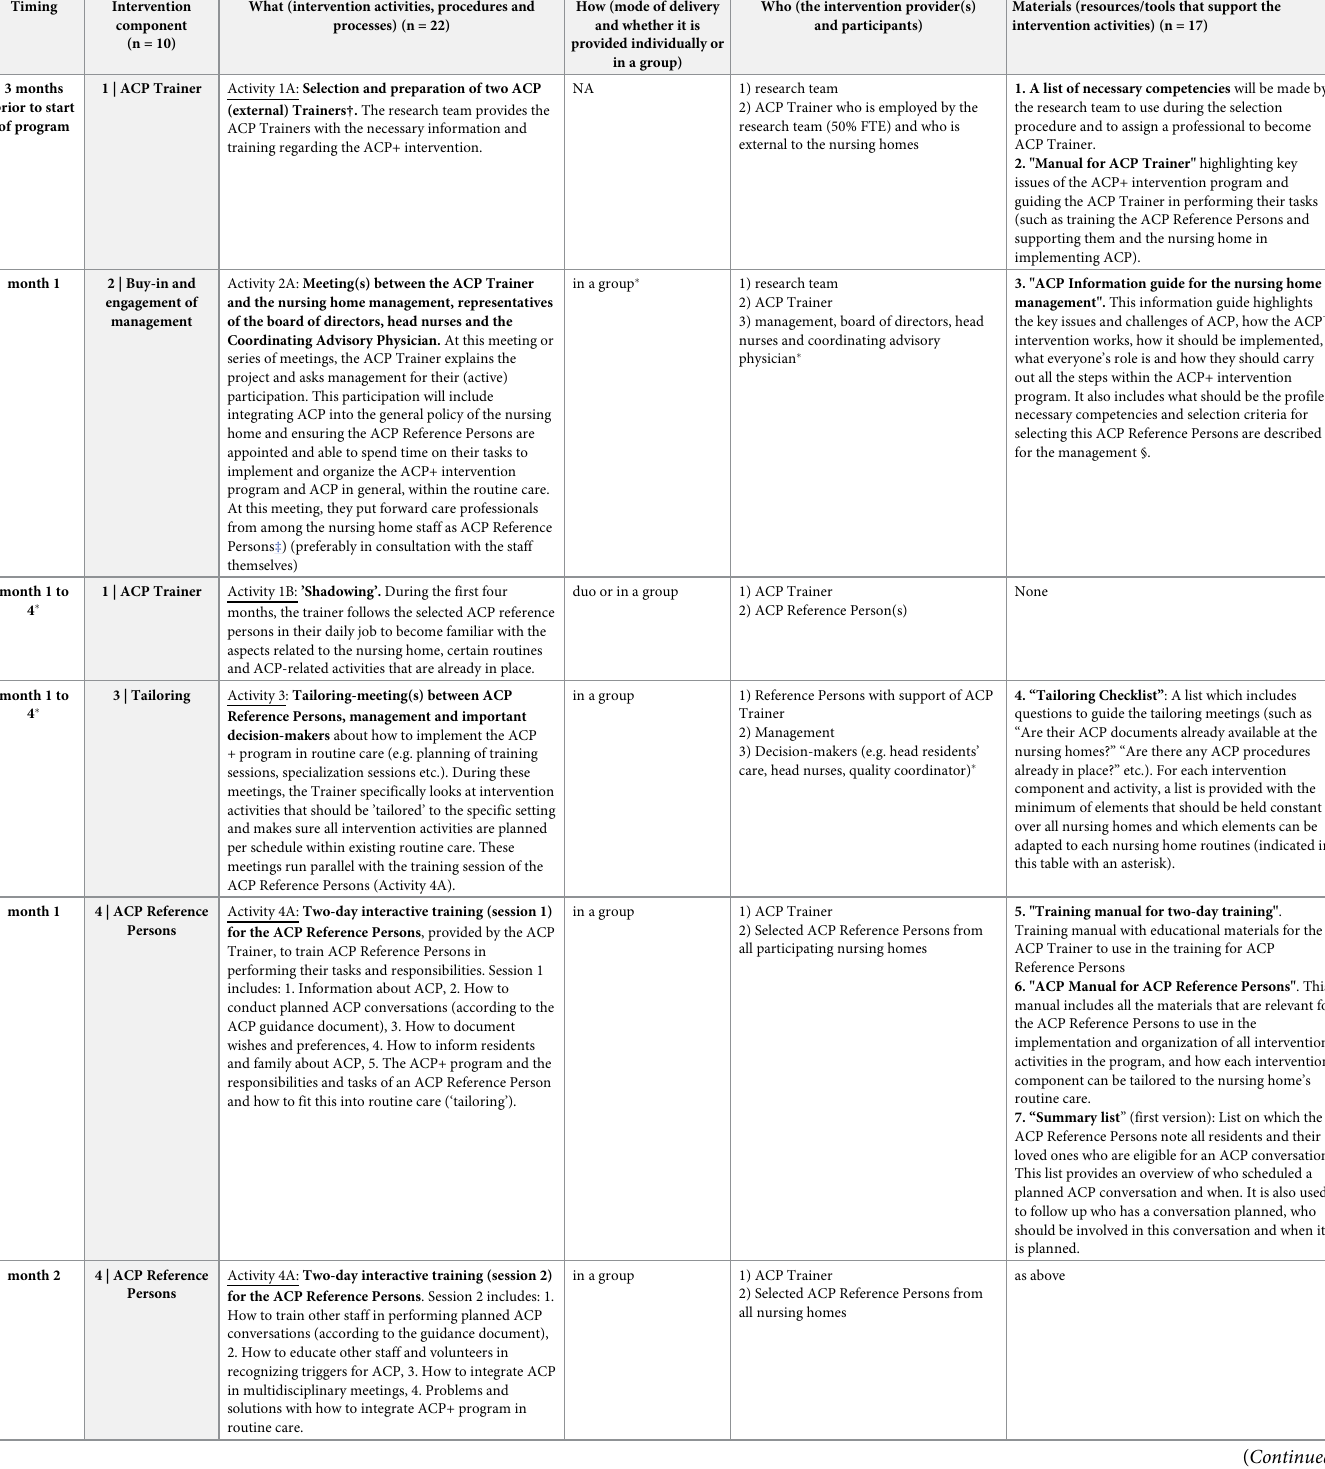
Table 2. Description of final intervention according to TIDieR: The ACP+ program (results of step